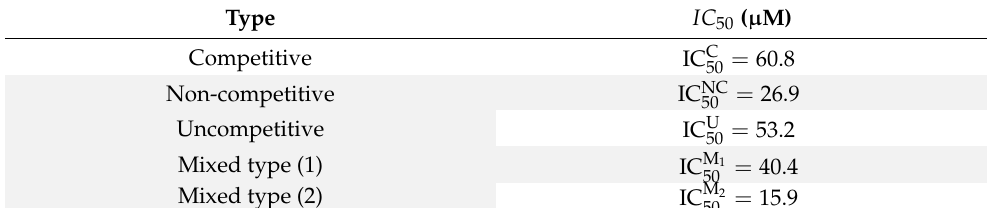
Table 4. Determination of the IC 50 values for the different types of